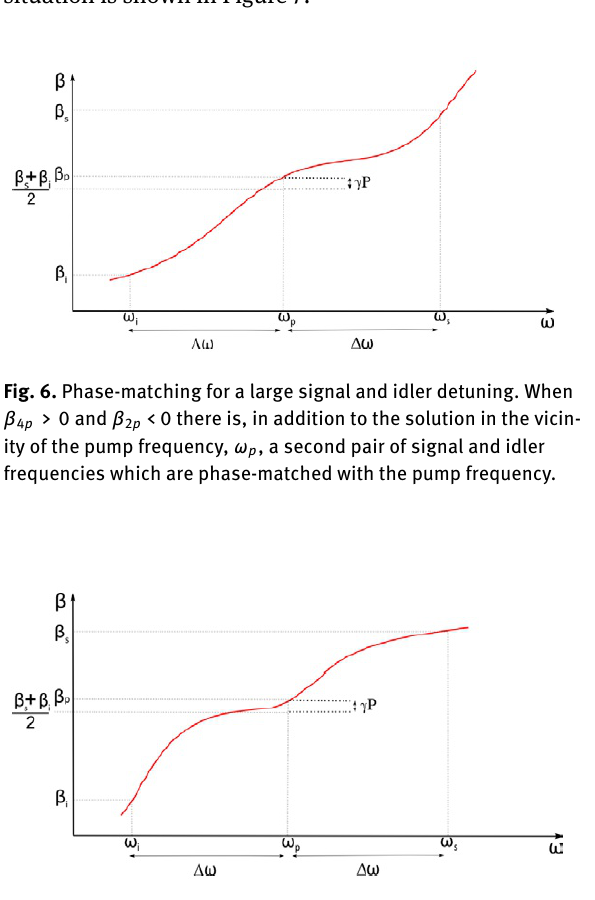
Fig. 7. Phase-matching for a very large signal and idler detuning. When β 4 < 0 and β 2 > 0, there is only one pair of signal and idler p p frequencies that are phase-matched with the pump